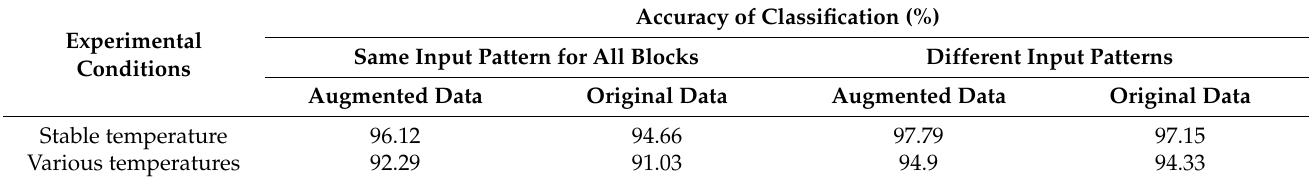
Table 6. Accuracy of classification considering different scenarios (N = 100, M =